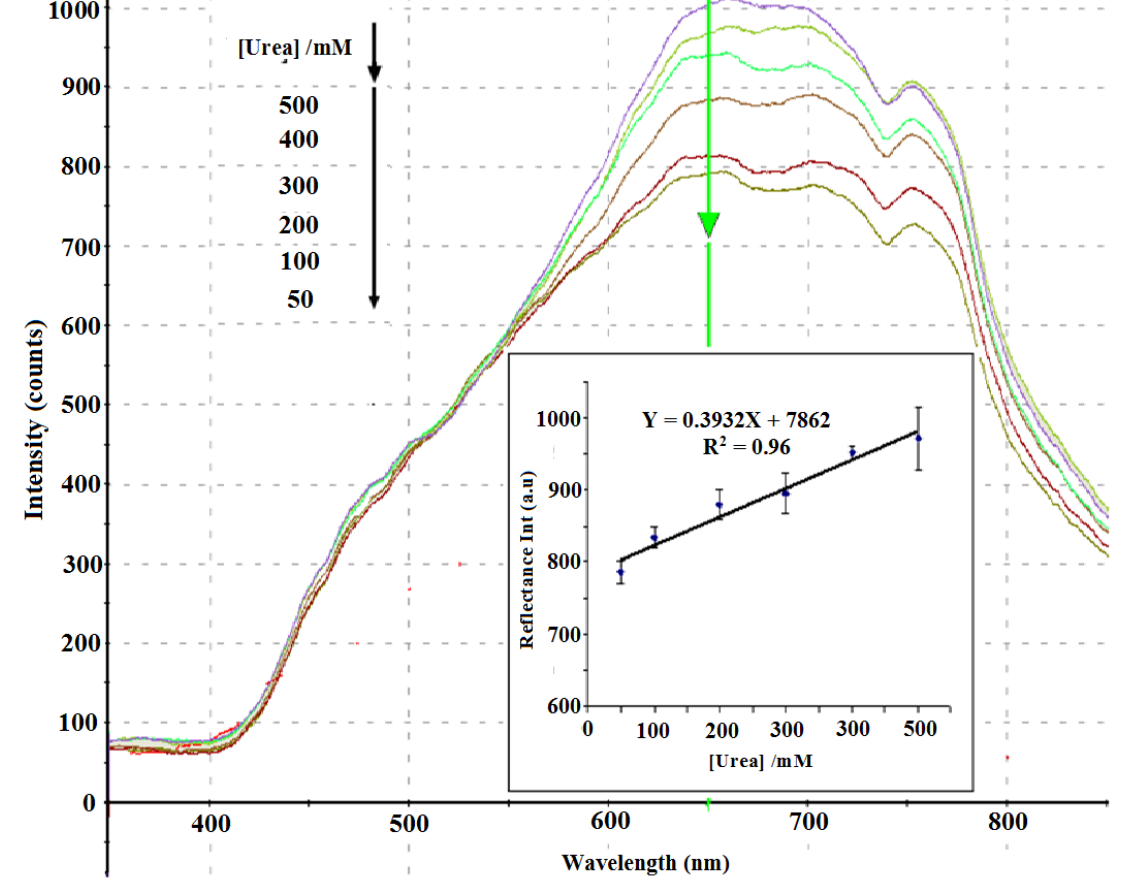
Figure 9. Reflectance spectra and calibration curve of urea biosensor obtained in the urea concentration range of 50–500 mM at 0.05 M phosphate buffer (pH 7) ( n =